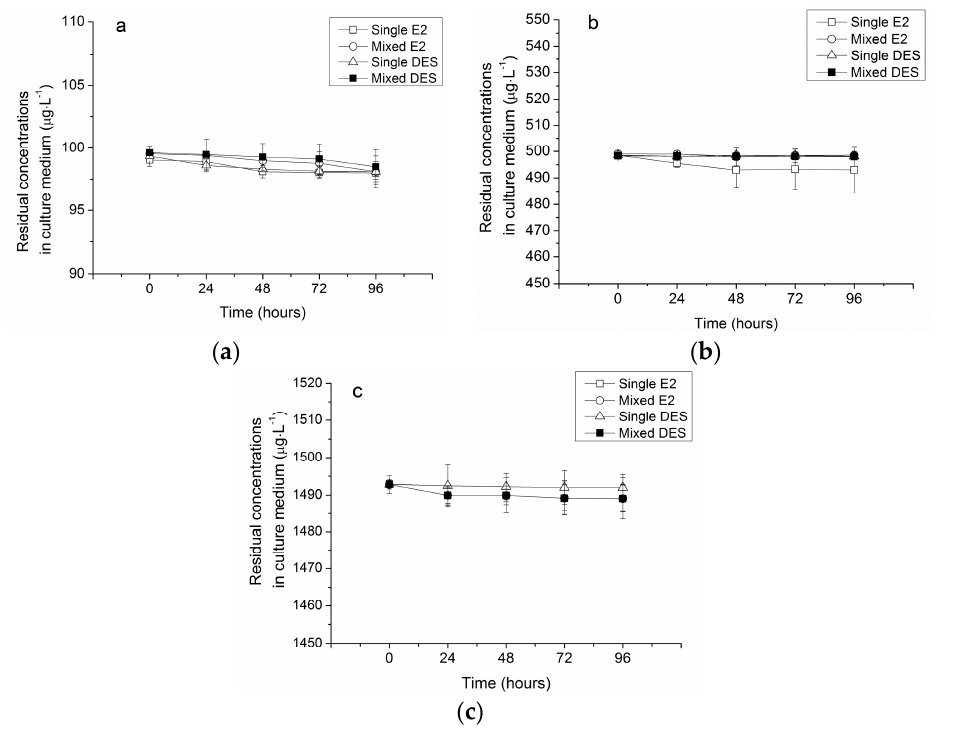
Figure 2. Residual concentrations of E2 and DES in culture medium without microalgae: ( a ) 0.1 mg/L; ( b ) 0.5 mg/L; and ( c ) 1.5 mg/L initial spiked values. Values are the mean ± standard deviation (SD) ( n = 3).